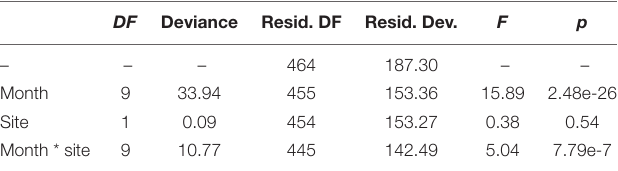
*Indicates the interaction between these two